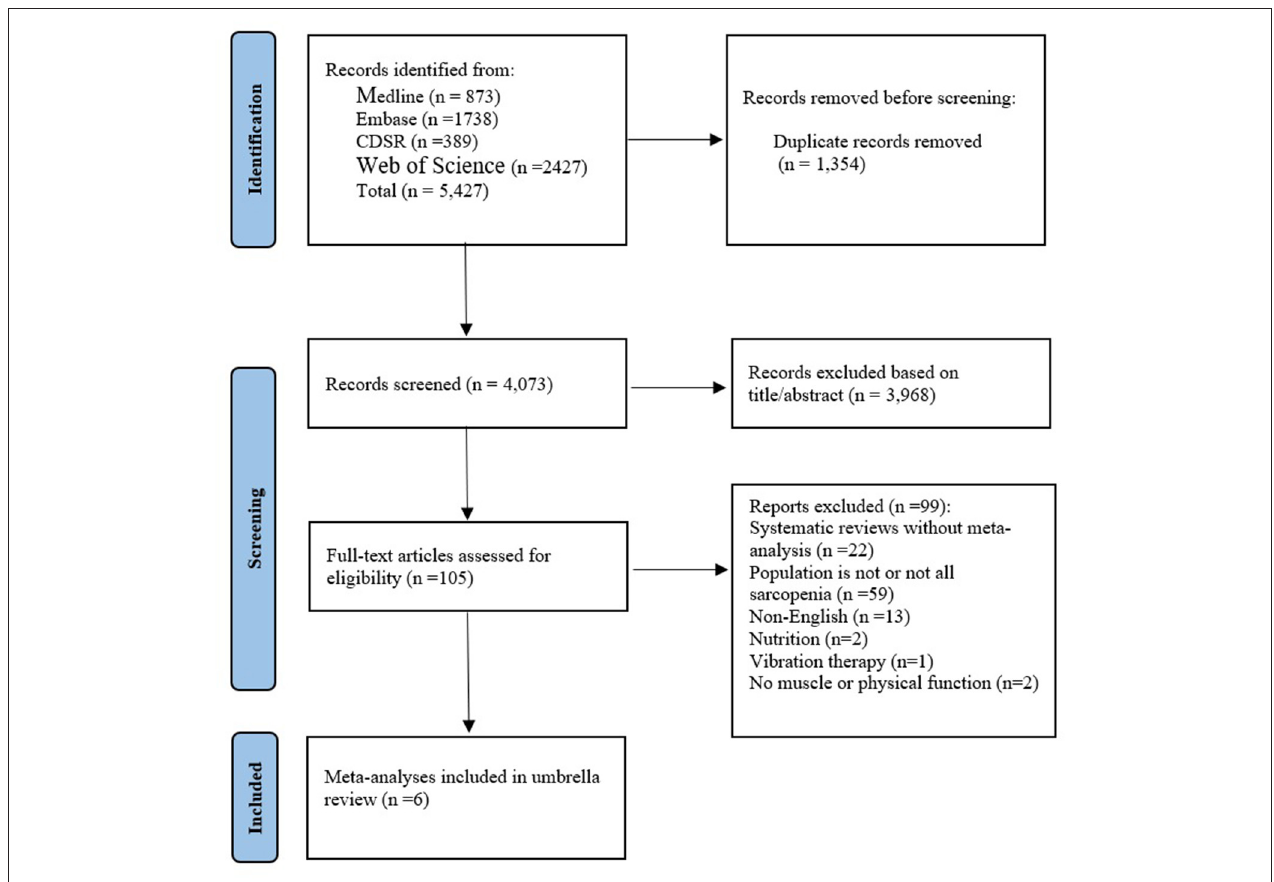
FIGURE 1 | Evidence searches and